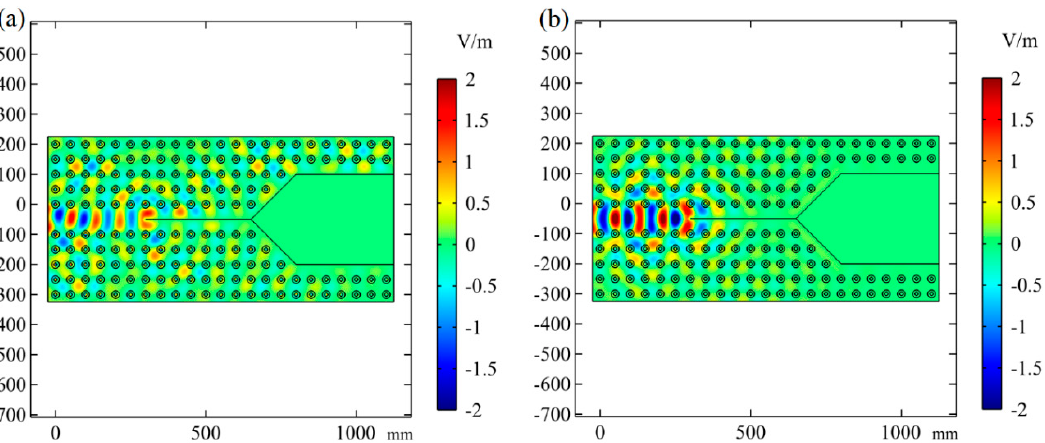
Figure 7. The electric field distribution for the Y-shaped waveguide when ( a ) the plasma is absent or ( b ) the external magnetic field is absent.